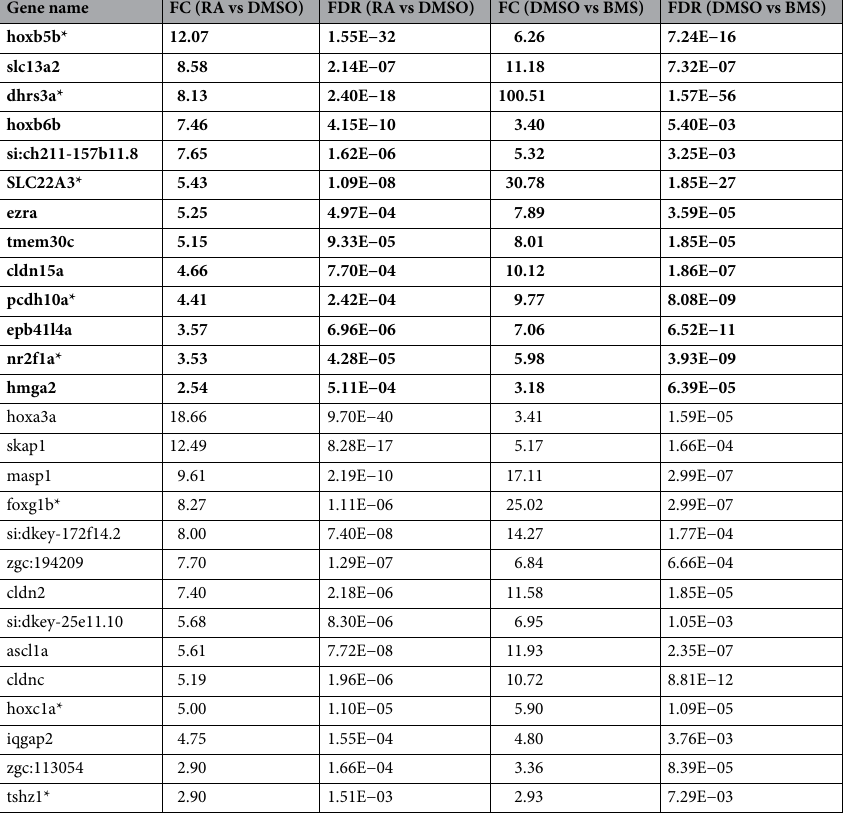
Table 2. List of genes up-regulated by RA and down-regulated by BMS493 at 8-somites stage (with FDR < 0.01). The regulation of each gene is shown by the Fold Change expression ratio (FC) and with the False Discovery Rate (FDR) for the RA treatment (column 2 and 3) and for the BMS493 treatment (columns 4 and 5). The genes highlighted in bold are those showing enriched expression in endoderm (FC > 4 and FDR < 0.01). Genes displaying the same regulation at 3 somites (Table 1) are shown by an